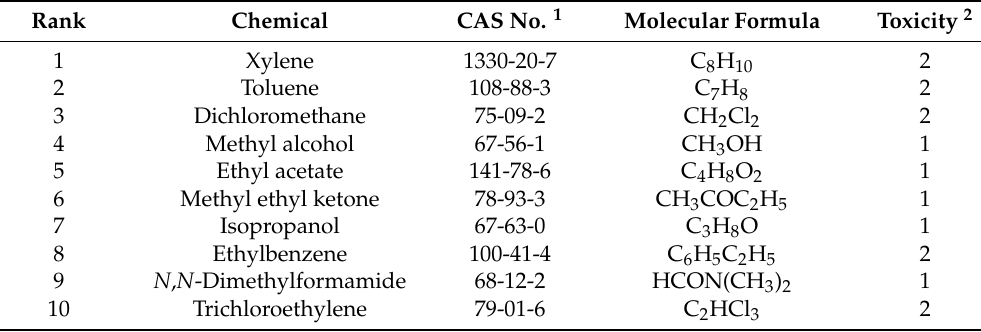
Table 2. Top ten chemicals released in the Nakdong River Basin in 2011 and